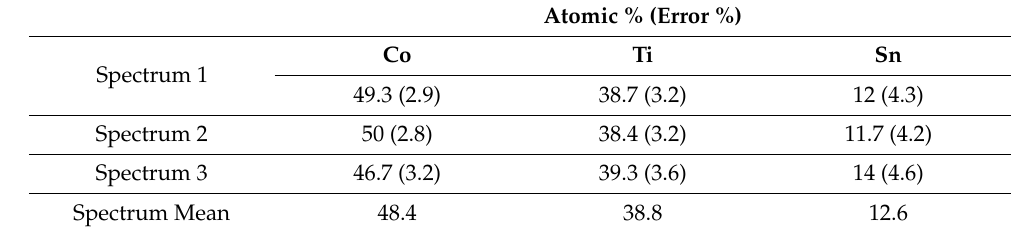
Table 1. EDAX result for Co 2 Ti 1.5 Sn 0.5 alloy.